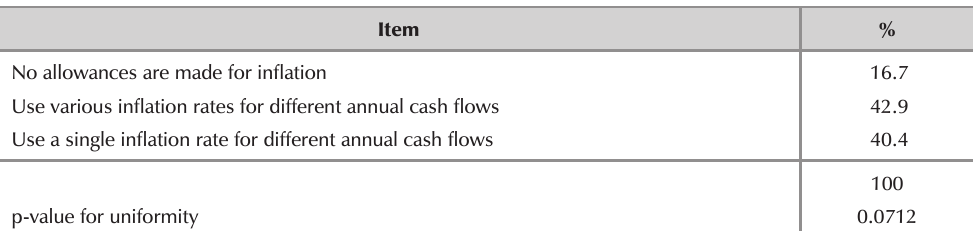
Adjustments to accommodate fluctuations in the inflation